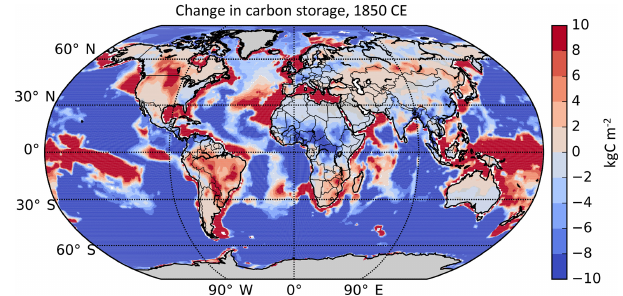
Figure 4. Combined map of changes in the ocean carbon storage (vertically integrated ocean water column plus sediments minus weathering) and land (soil plus vegetation) at the end of the TRAFc simulation (1850CE) relative to 6000BCE (in kgCm − 2 ).